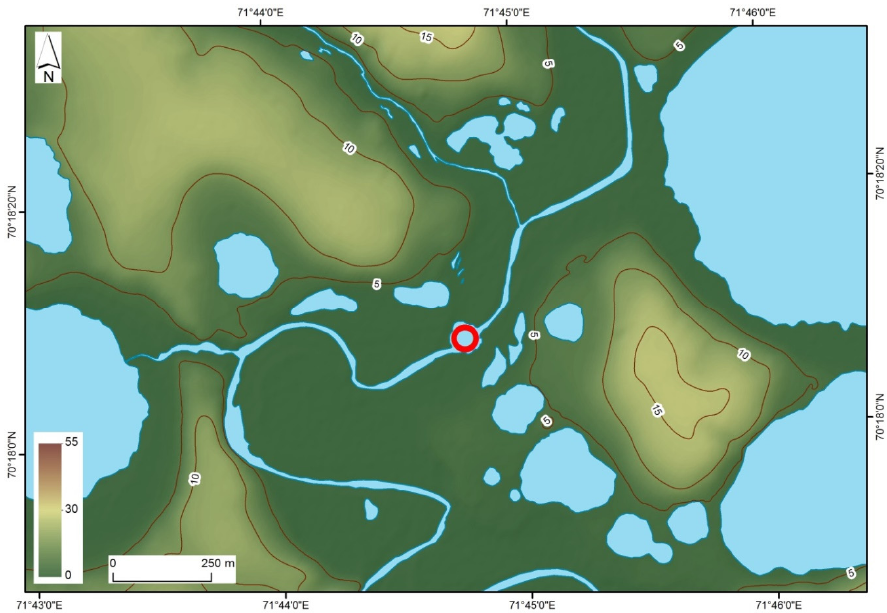
Figure 3. SeYkhGEC location on ArcticDEM fragment (red circle). The river pattern was digitized using the SPOT7 image dated 27 July 2017. Mounds’ base ranges between 20 to 55 m in diameter. The diameter of SeYkhGEC